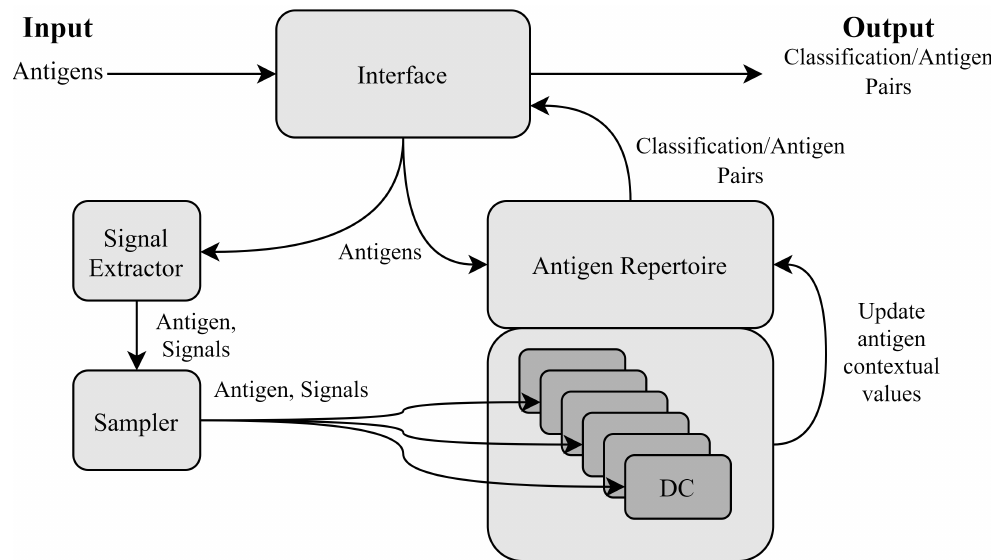
Figure 7. Modular approach for DCA. Each modules consists on a step in the data-flow of the algo-